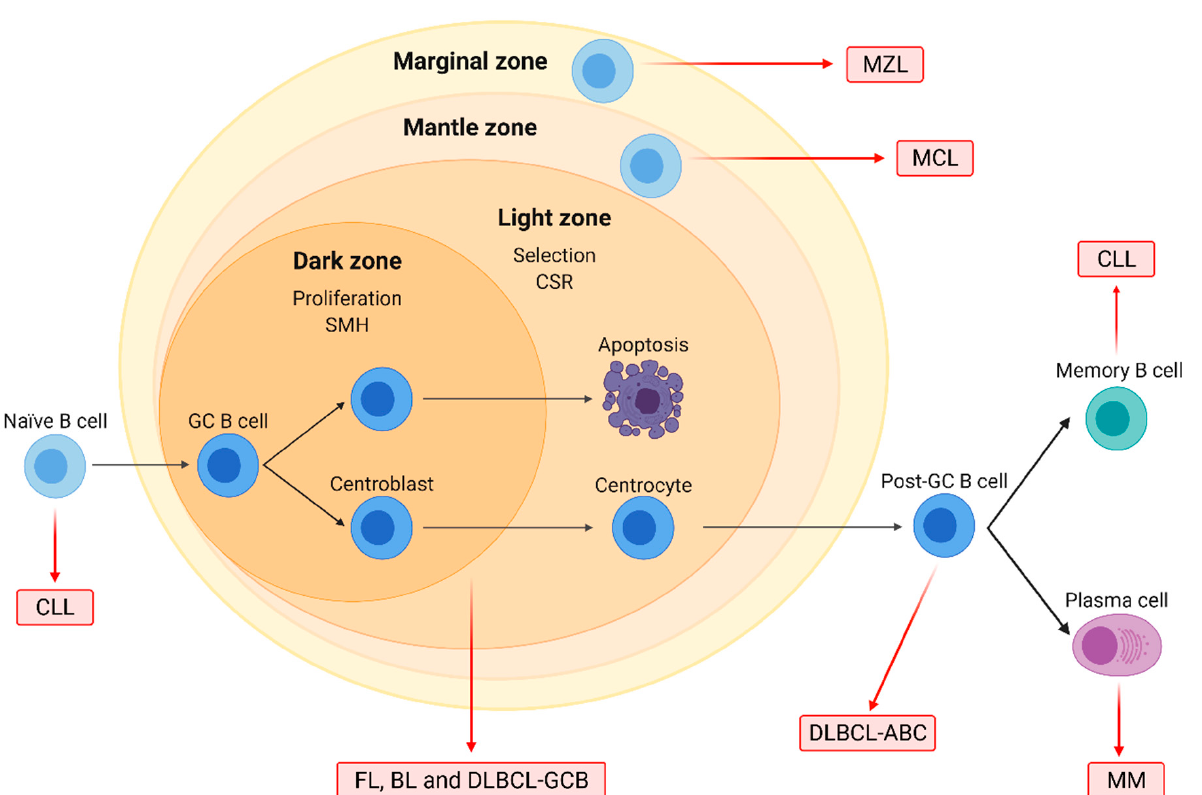
Figure 1. Origin of the major B-cell non-Hodgkin lymphoma (B-NHL) subtypes. Naïve B-cells form germinal centers (GC) after interacting with antigens. In the dark zone, centroblasts proliferate and undergo somatic hypermutation (SMH), while in the light zone, centrocytes are selected based on BCR affinity and undergo class-switch recombination (CSR). GC cells are the normal counterparts of follicular lymphoma (FL), Burkitt lymphoma (BL), and diffuse large B-cell lymphoma (DLBCL) of the GC subtype (GCB). DLBCL of the activated B-cell (ABC) subtype originates from post-GC cells, and multiple myeloma (MM) arises from differentiated plasma cells. Chronic lymphocytic leukemia (CLL) may originate from either naïve or differentiated memory B cells. Mantle cell (MCL) and marginal zone lymphoma (MZL) arise from B cells located on the mantle and the marginal zone of lymphoid follicles, respectively.